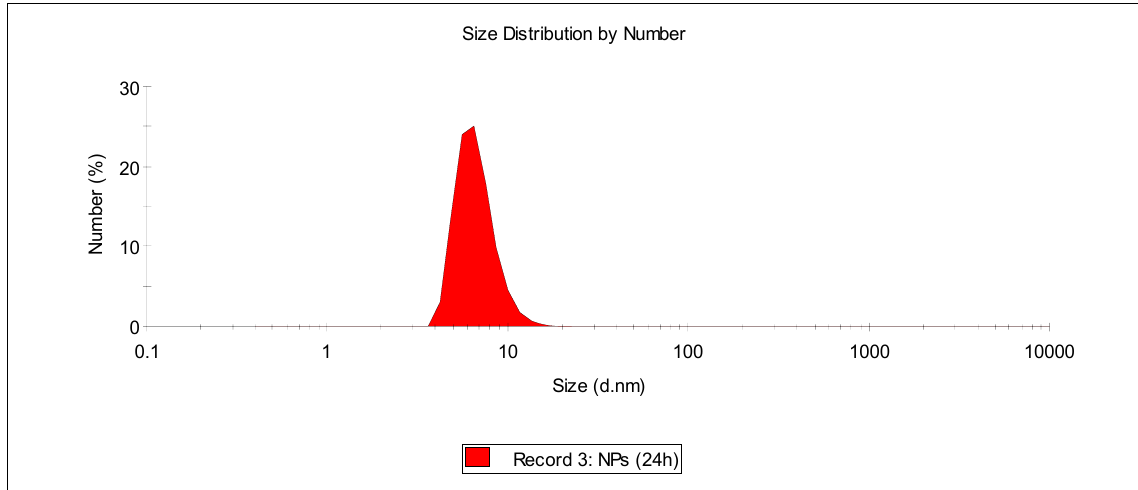
Figure 6. Size distribution of PMMA-NPs 2a in THF by